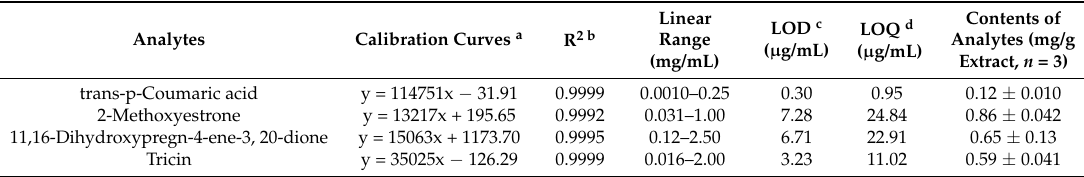
Table 2. Content of analytes in IMP aerial part ethyl acetate extract.